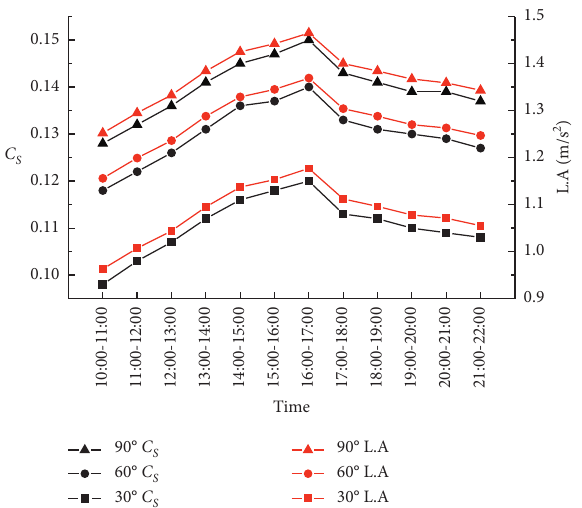
Figure 2: C S and lateral acceleration at K1142.6 and K1158 on 28 July. Figure 1: The impact of different wind angles to the lateral force